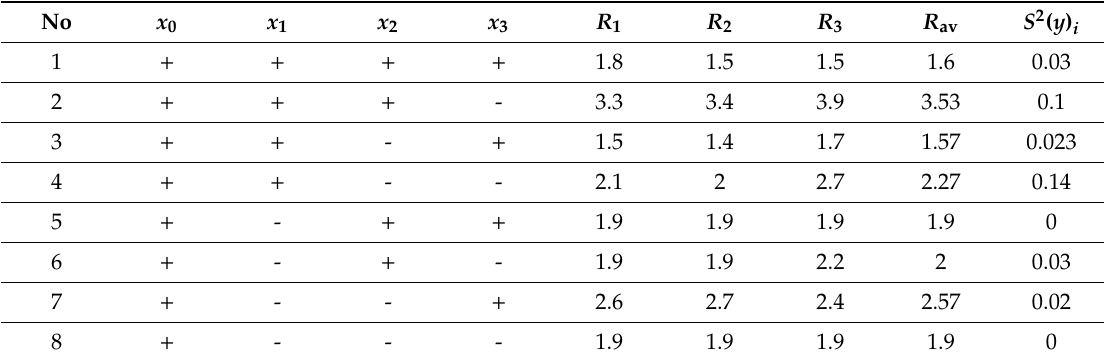
Table 2. Matrix of the experimental plan for power in the range 1–4 W.